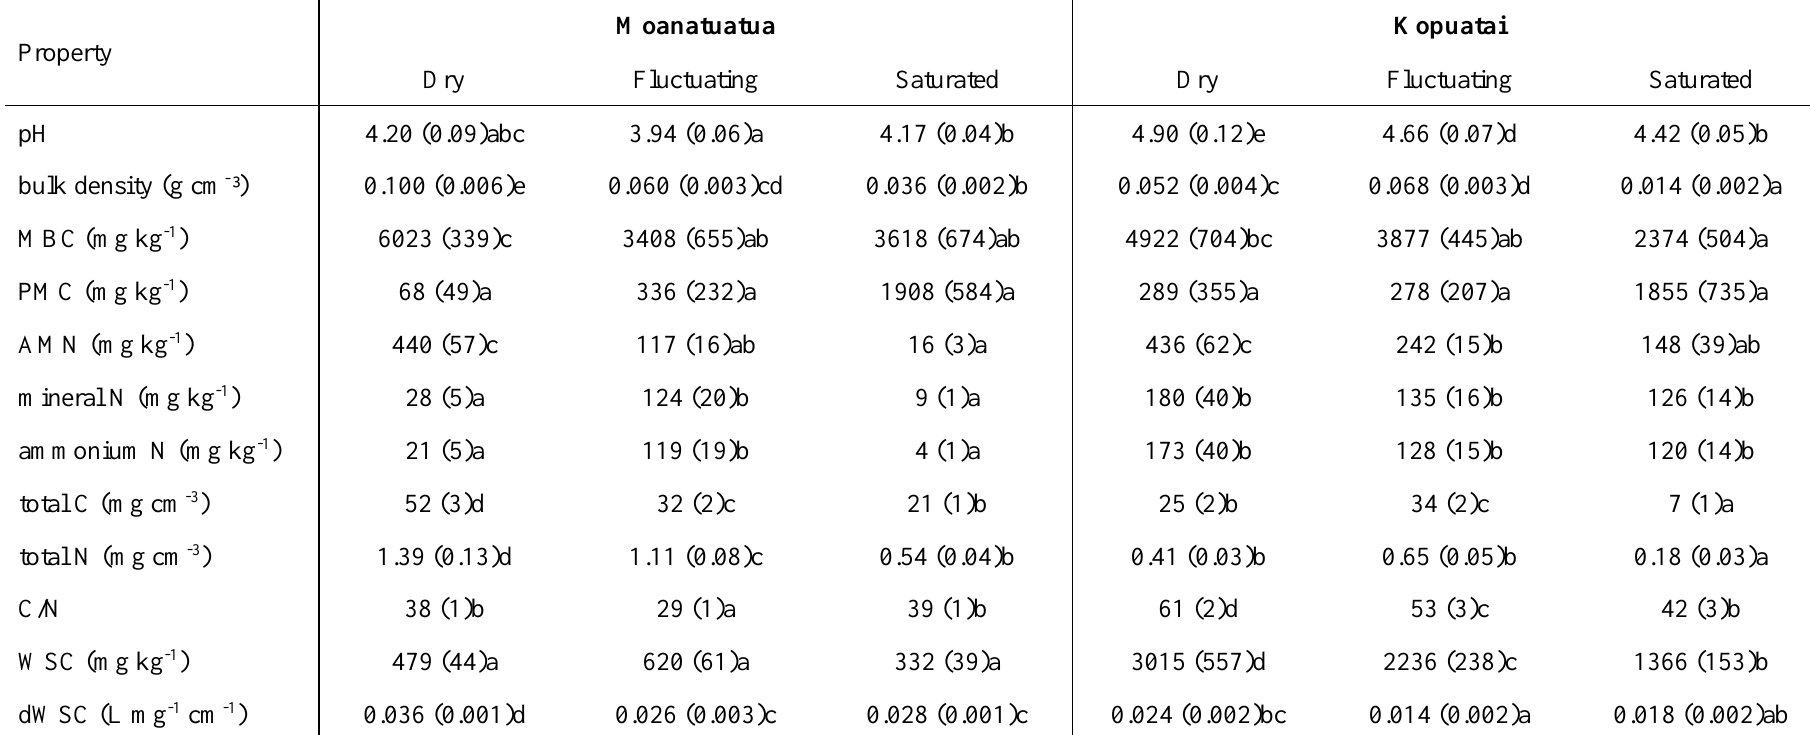
Table 3. Biochemical properties of peat in different hydrological zones at the Moanatuatua (degraded) and Kopuatai (intact) bogs. AMN = anaerobically mineralisable nitrogen, dWSC = decomposability of water-soluble carbon, MBC = microbial biomass carbon, PMC = potentially mineralisable carbon, WSC = water-soluble carbon. Values in brackets represent the standard error of the mean ( n = 8). Values with different appended letters within a row are significantly different ( P <